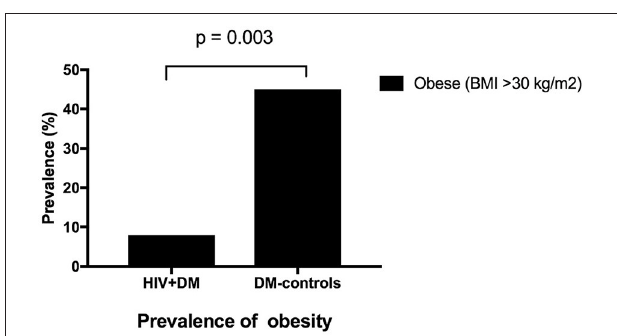
FIGURE 3 | Proportion of clinic attendees meeting individualized ADA benchmarks for HDL cholesterol (A), LDL cholesterol (B), and triglycerides (C) .